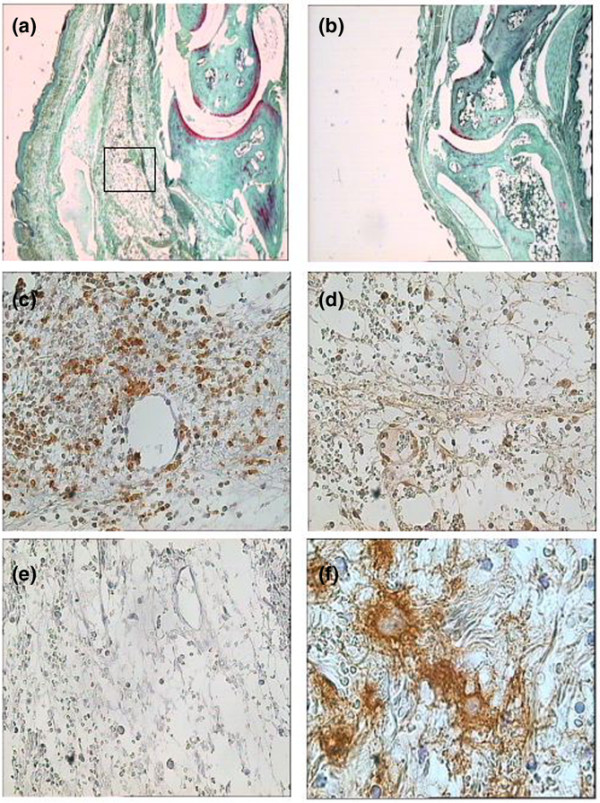
Footpad histology and immunohistochemistry. Samples were obtained 24 hours after soluble tissue factor injection. (a) Wildtype mice showed marked inflammatory changes. (b) Phosphate-buffered saline-injected mice showed minimal signs of inflammation. (c) Staining for macrophages was strongly positive. (d) CD3-positive T cells were also present. (e) Staining specificity was confirmed using, as primary antibody, nonimmune isotype-matched antibodies. (f) Fibrin deposition was assessed by fibrin immunohistochemistry.